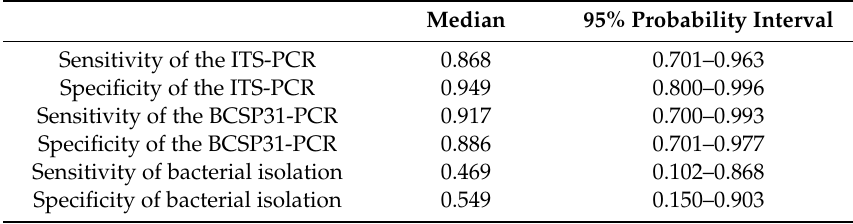
Table 8. Estimates of the diagnostic sensitivity and specificity of the PCR